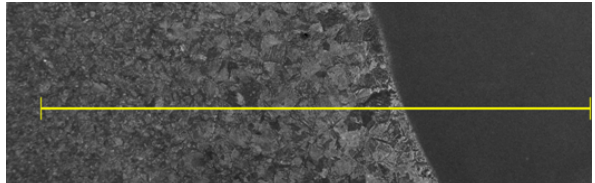
Figure 12: Measure line of HAZ and weld of S235JR steel for chemical analyze